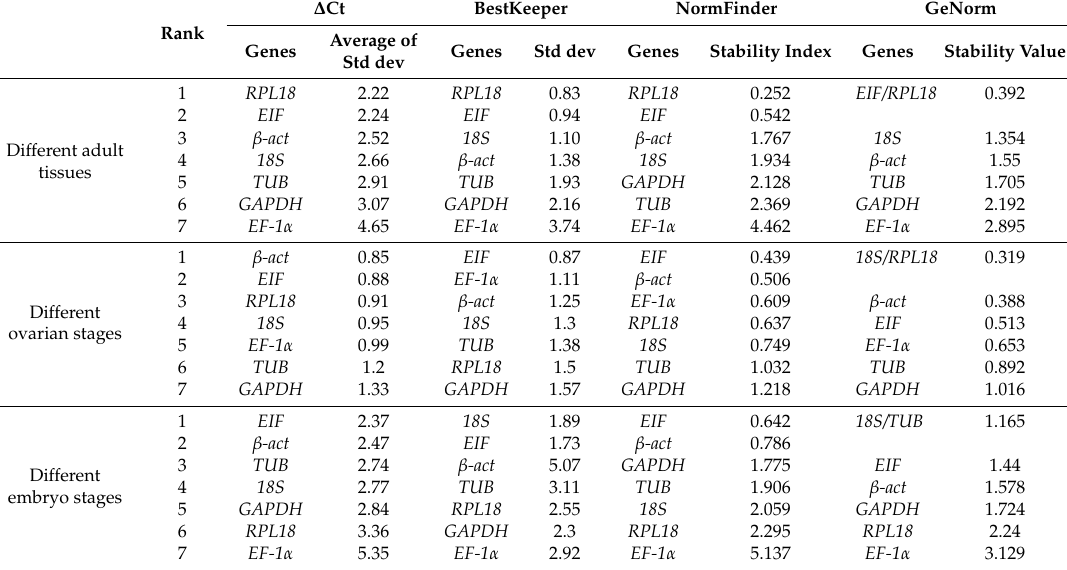
Table A3. Reference gene expression stability values based on several